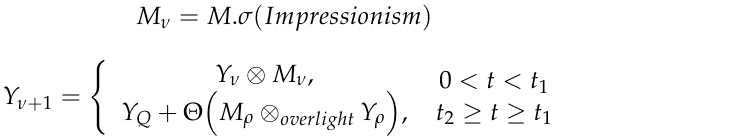
Figure 28. Fast communication of impressionism based on Monet’s painting “Impression”—Scene 3.